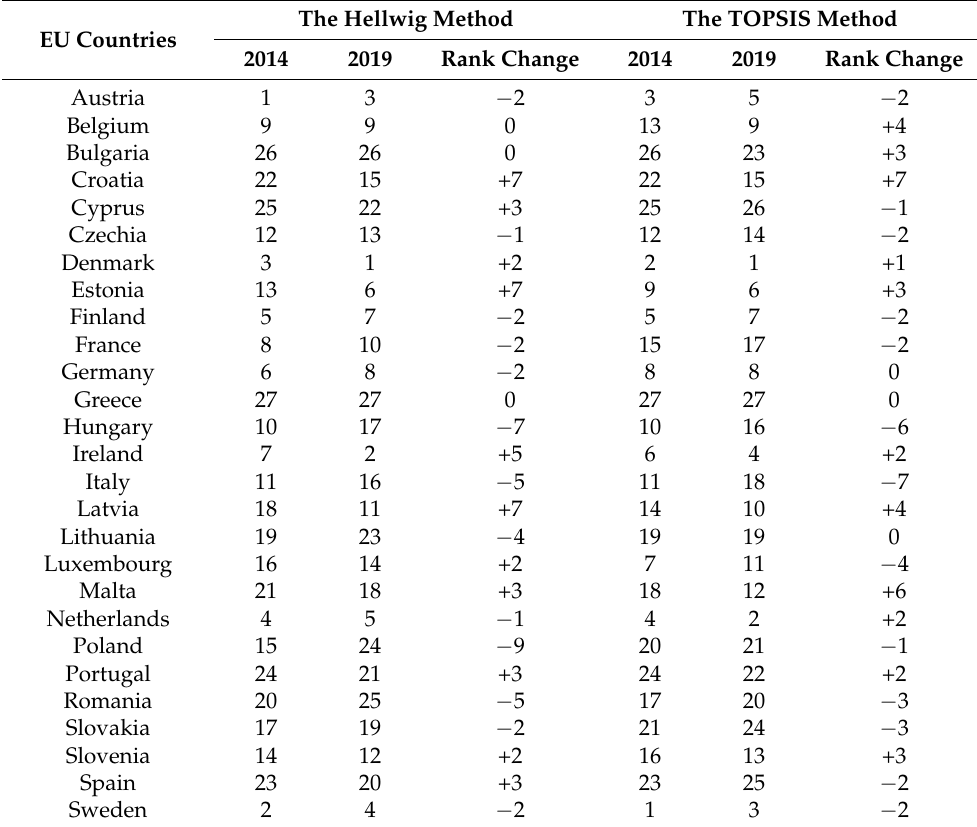
Table 3. Ranking of EU